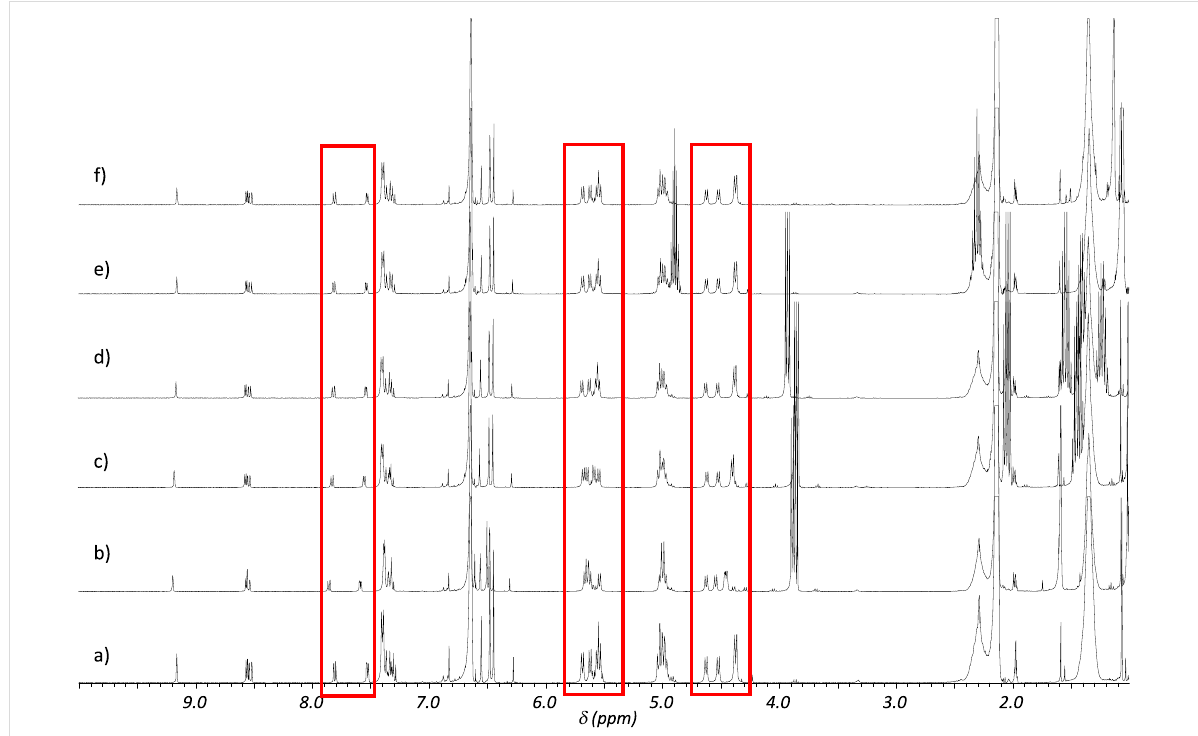
Figure 1: Qualitative binding studies of 2 and the model substrates 3 – 7 . 1 H NMR spectra (500.1 MHz, 298 K in mesitylene- d 12 , c 0 ( 2 ) = 5 mmol/L) of a) 2 , b) 2 and 15 equiv of 3 , c) 2 and 15 equiv of 4 , d) 2 and 15 equiv of 5 , e) 2 and 15 equiv of 6 , f) 2 and 15 equiv of 7 . Marked in red rectangles are the regions of the signals of the acetal and some of the bipyridine hydrogen atoms of 2 .